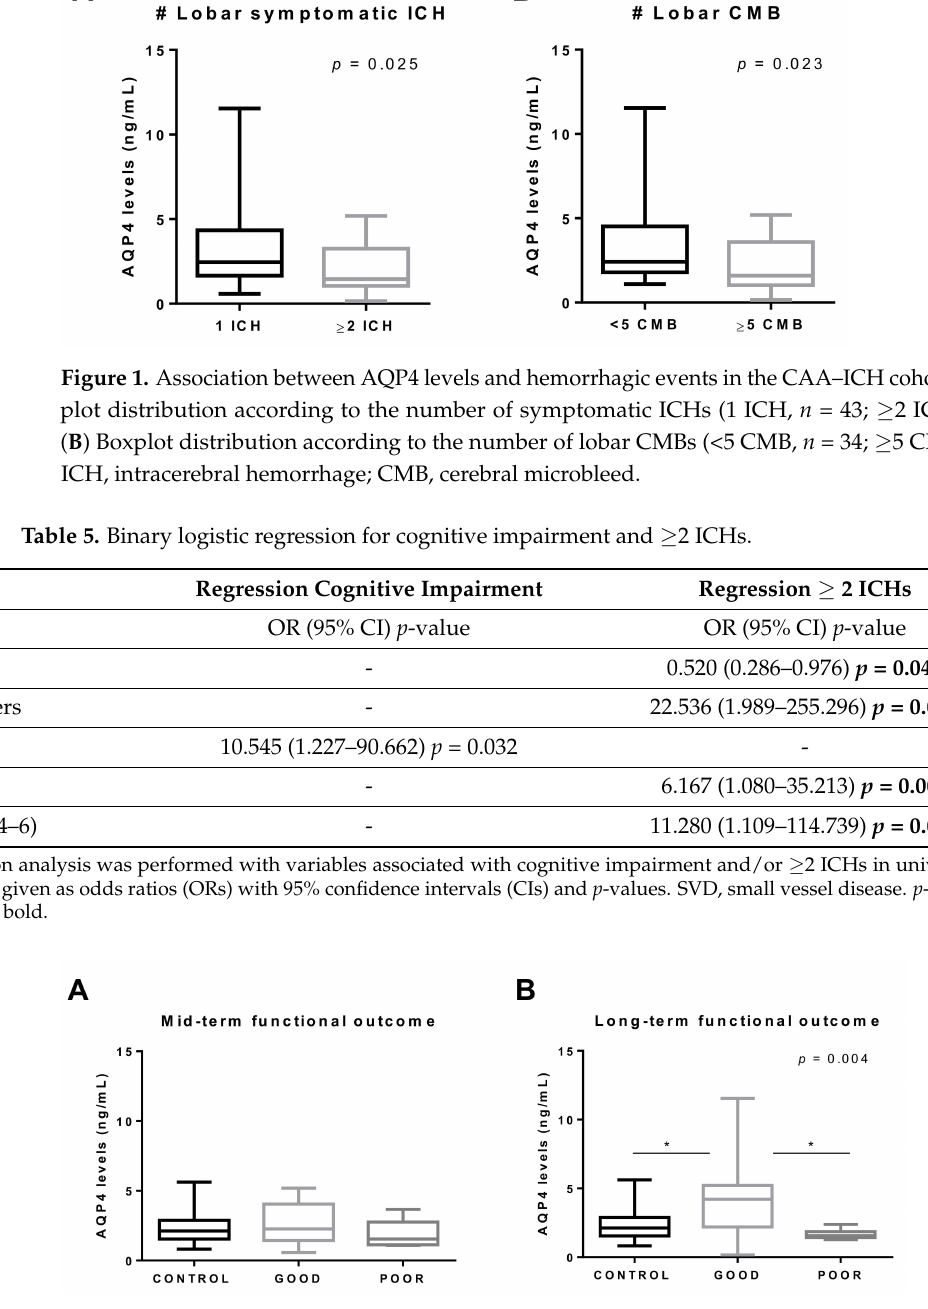
Figure 2. Association between AQP4 levels and functional neurological outcomes in the CAA–ICH cohort. ( A ) Boxplot distribution between good ( n = 27) and poor ( n = 7) mid-term functional outcomes (CAA–ICH subcohort 1) compared to controls ( n = 19). ( B ) Boxplot distribution between good ( n = 17) and poor ( n = 8) long-term functional outcomes (CAA–ICH subcohort 2) compared to controls ( n = 19). Outcomes were dichotomized into good vs. poor, and good outcomes were predefined as 0–3 on the modified Rankin Scale for Neurologic Disability. ICH, intracerebral hemorrhage; CMB, cerebral microbleed. * p <